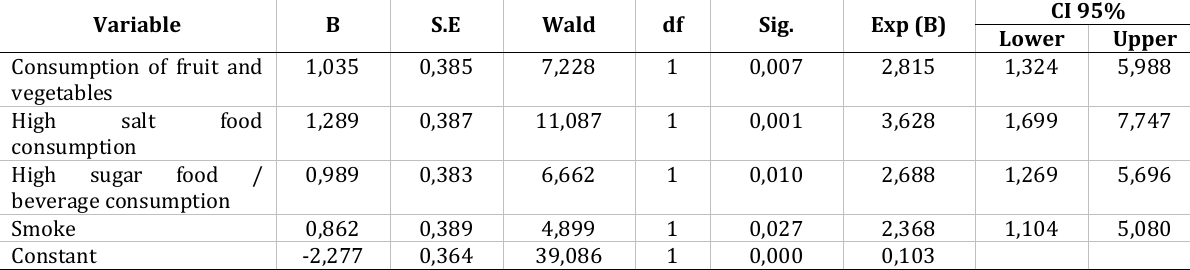
Table 1. Variables Triggering Factors of Risk of Death of Fathers due to the Highest Non-Communicable Diseases (Primary Hypertension) the Most